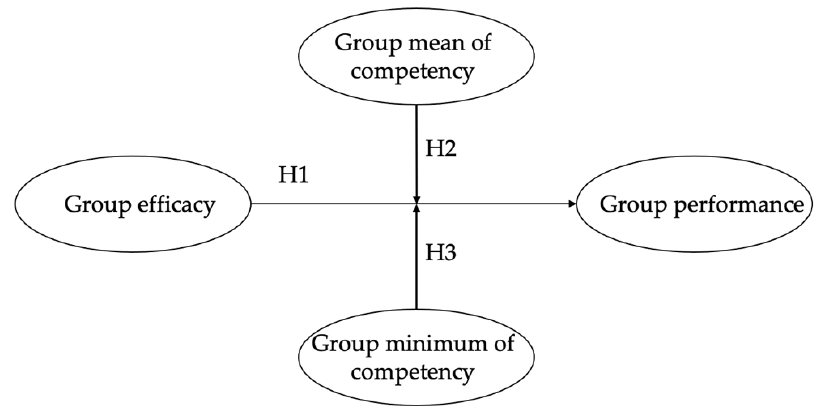
Figure 1. Research Model.